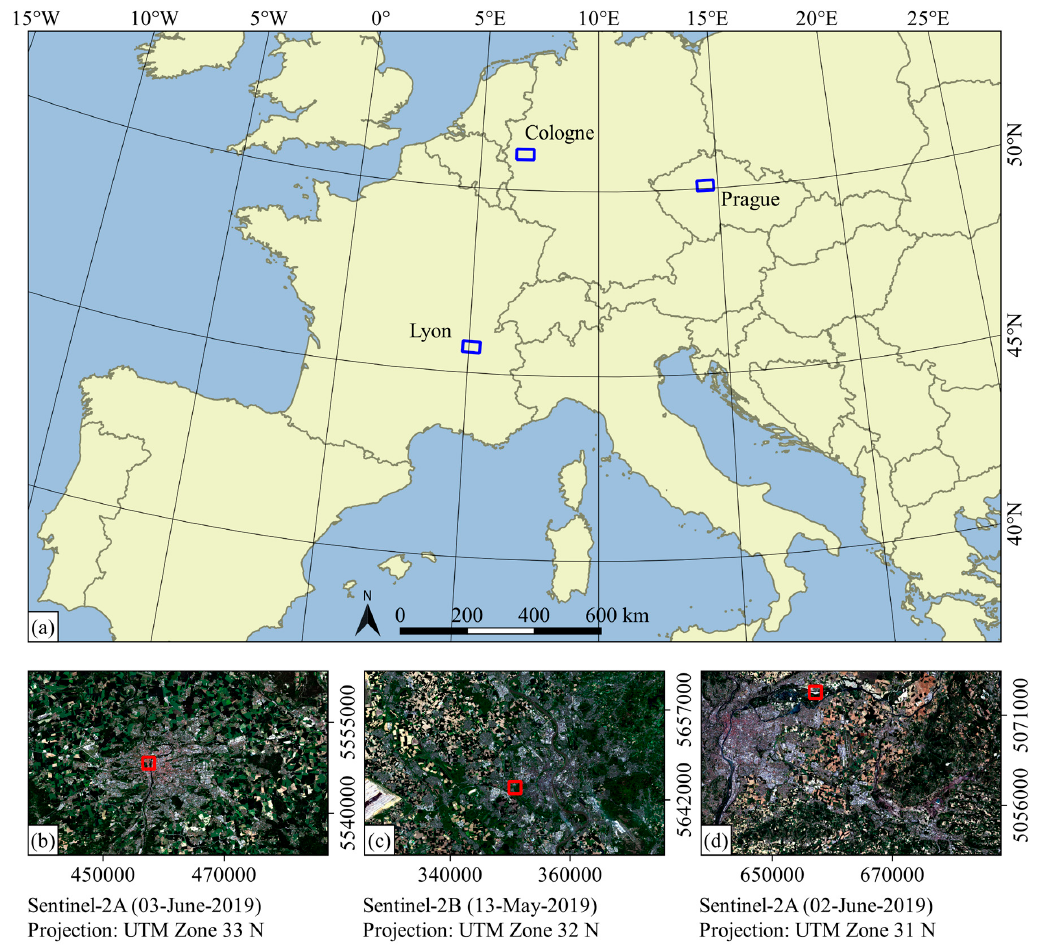
Figure 2. ( a ) Locations across Europe used in this research; ( b ); ( c ); and ( d ) show the study areas located in Prague; Cologne; and Lyon, respectively, whereas the red square represents an example subset location for a classification map, with an extent of 2 km × 2 km.